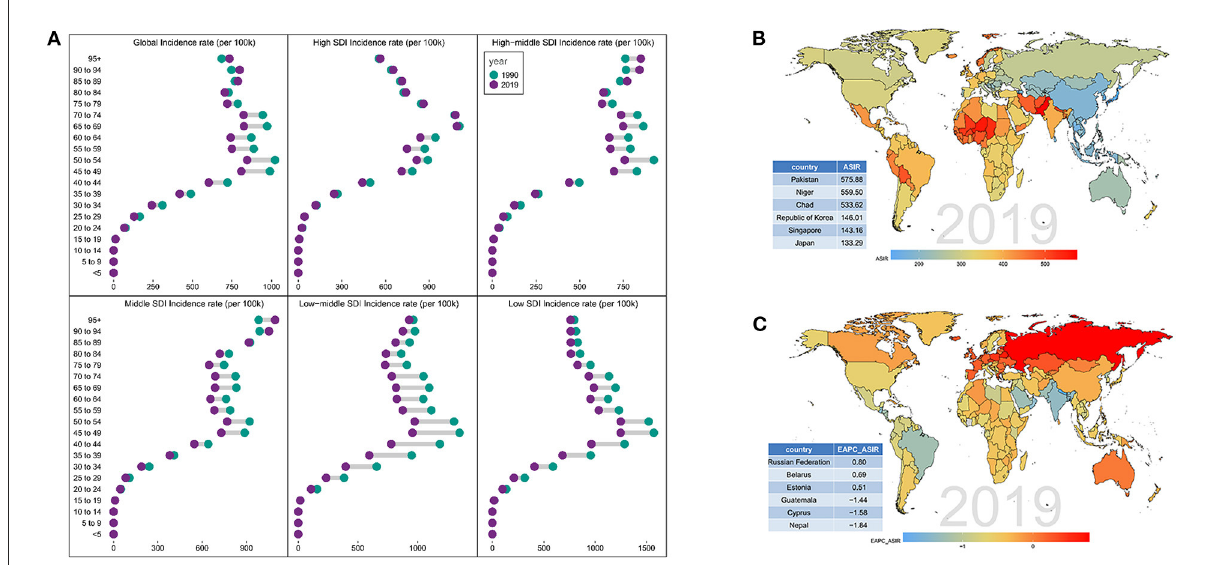
FIGURE2 Distribution of incidence rate in different SDI regions. (A) Age distribution of incidence rate in different SDI regions from 1990 to 2019. Distribution of (B) ASIR and (C) EAPC-ASIR in various countries and regions in 2019.